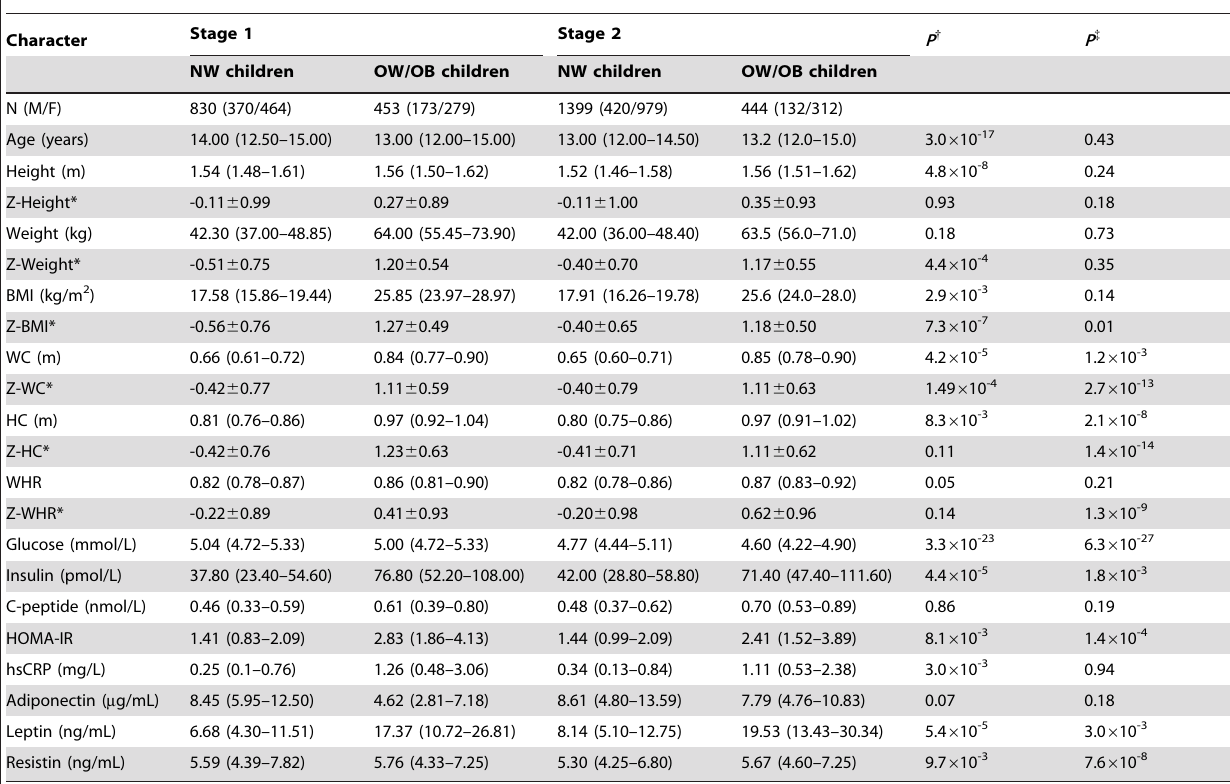
Table 1. Clinical characteristics of